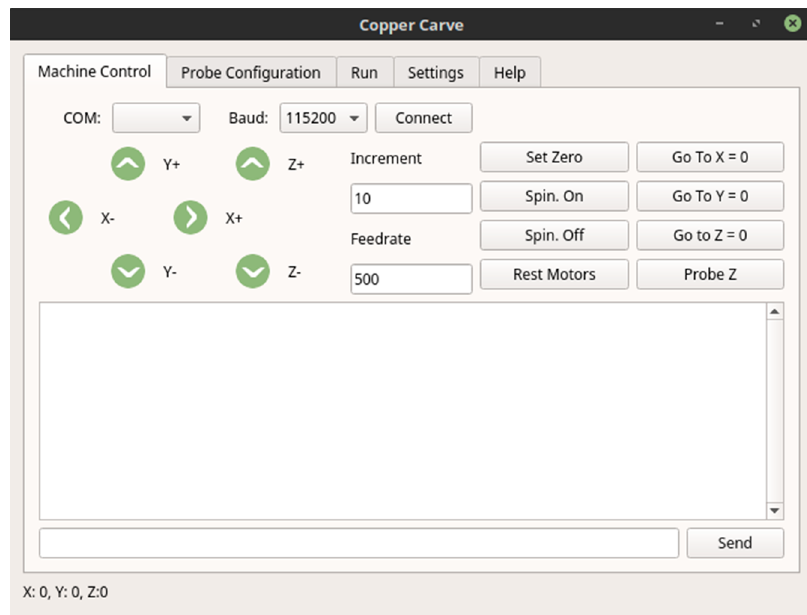
Figure 4. The machine control interface of Copper Carve.